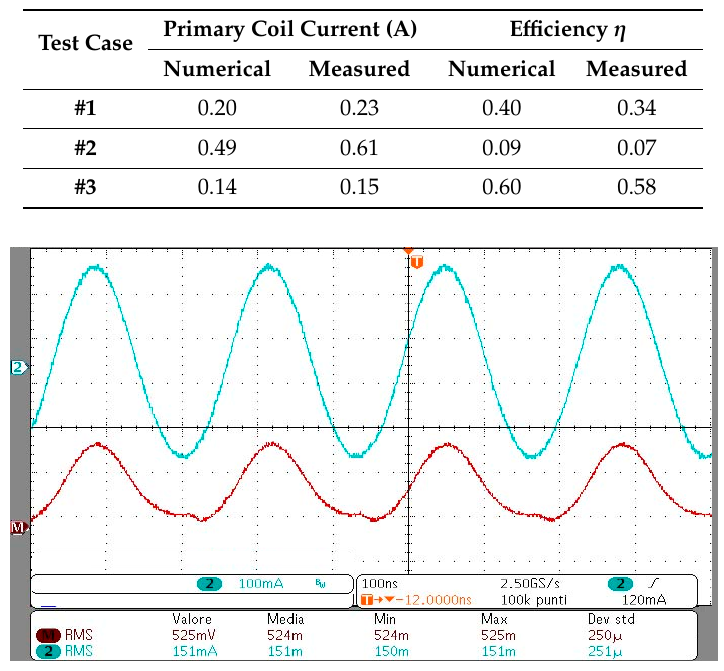
Figure 18. Measured waveforms of the input voltage V in (red line) and input current I 1 (light blue line).